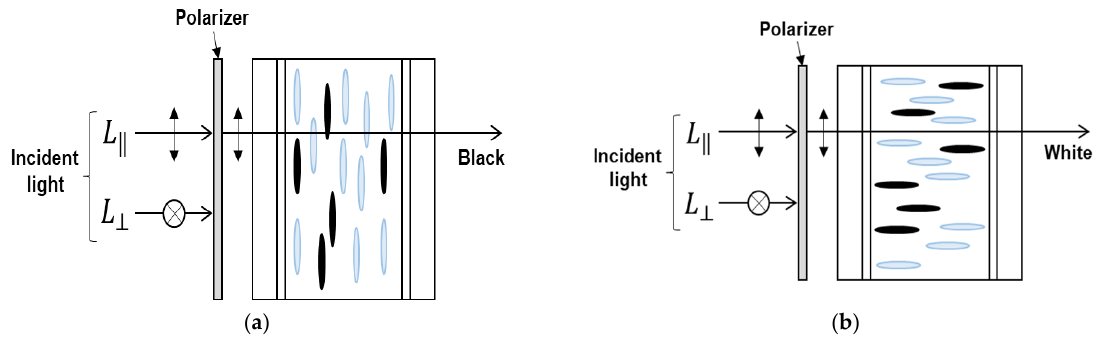
Figure 2. A switching window for the polarized mode transparent OLED cell using a dye doped LC mode with the Heilmeier structure: ( a ) Dark state and ( b ) Bright state.